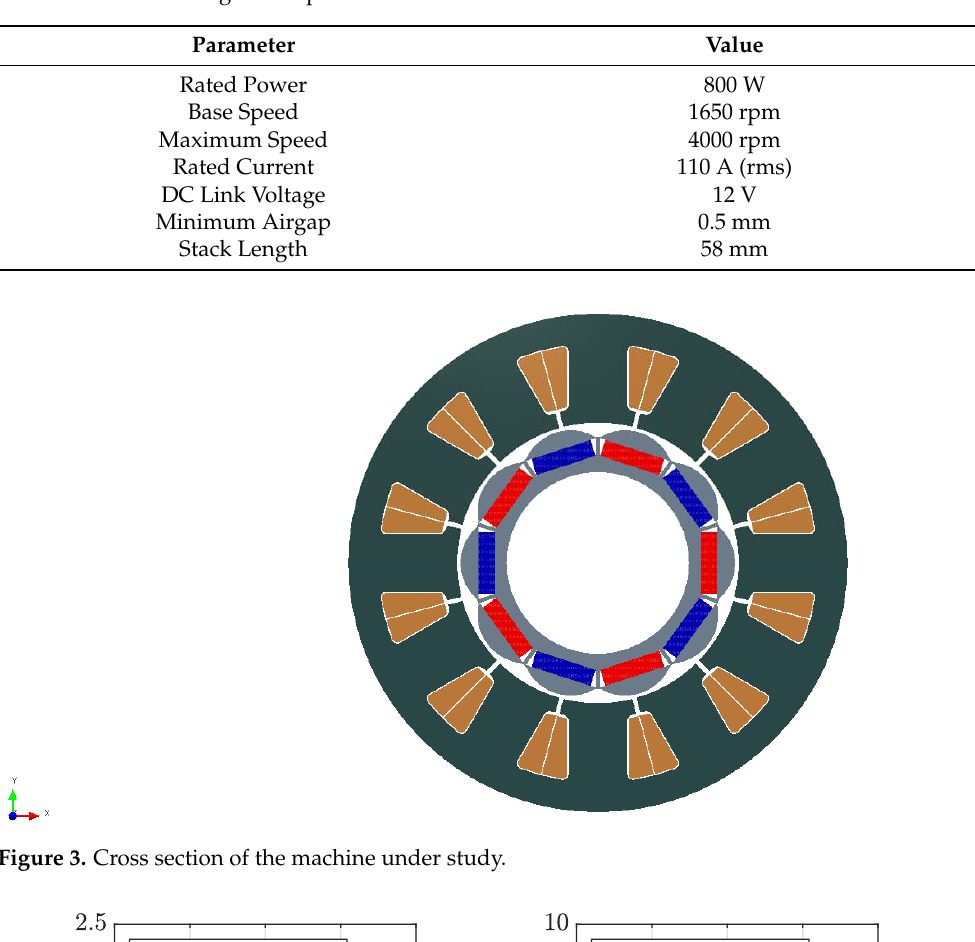
Table 2. Power steering IPSM specifications.